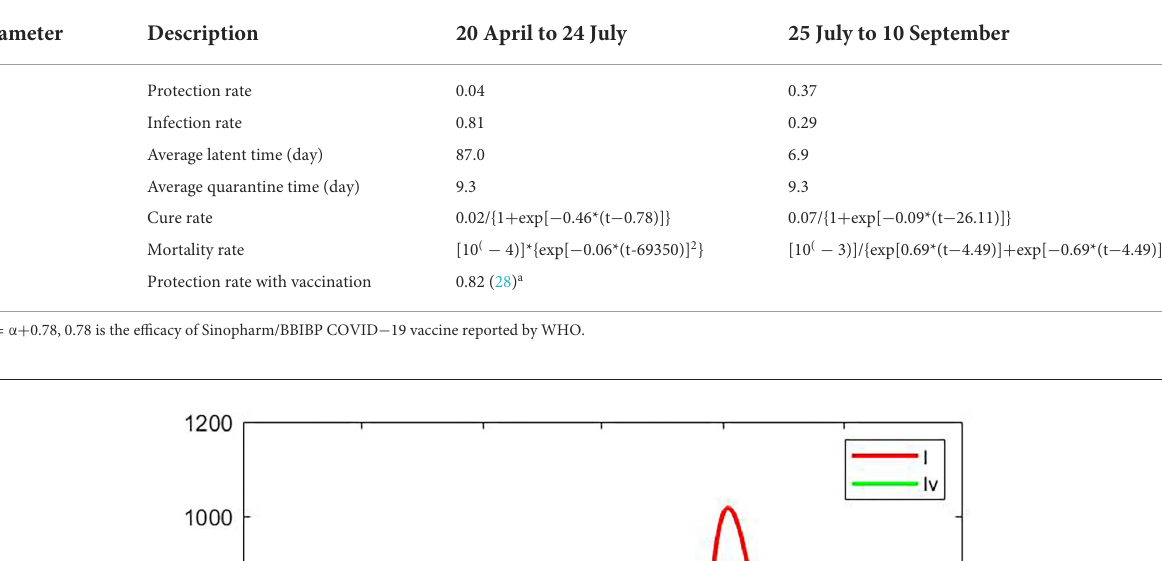
TABLE 3 Values for unknown parameters in the fitted SEIR model.